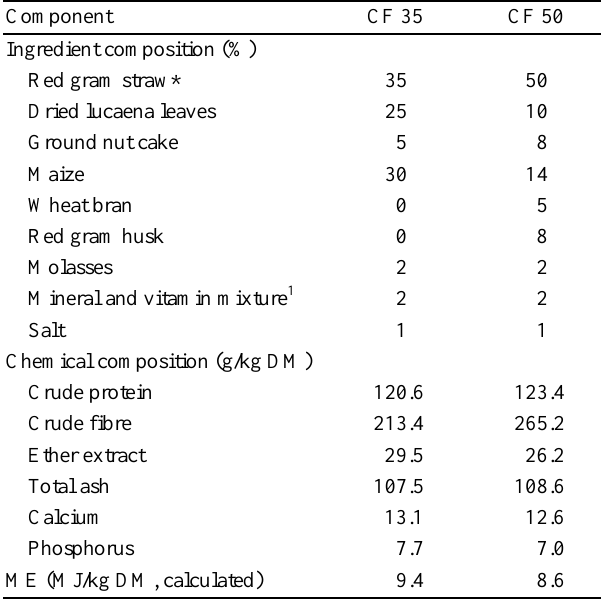
Table 1. Ingredient and chemical composition of complete